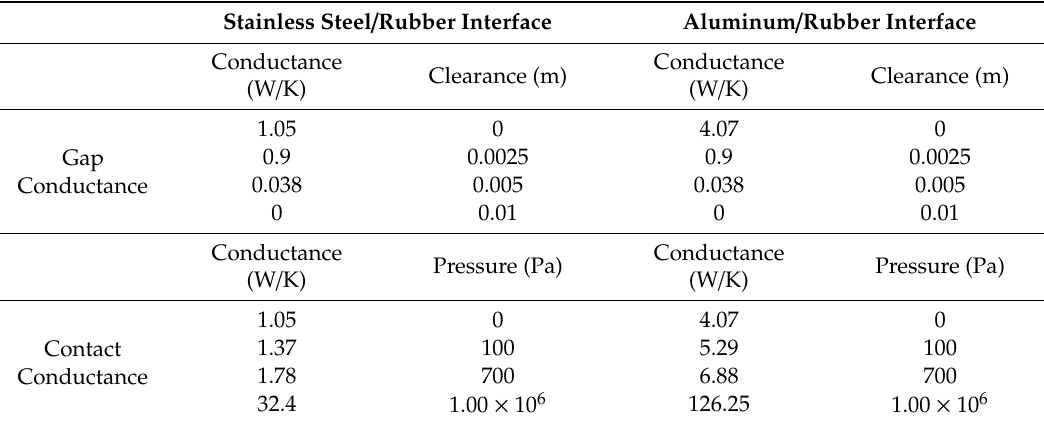
Table 2. Thermophysical contact properties used in the numerical